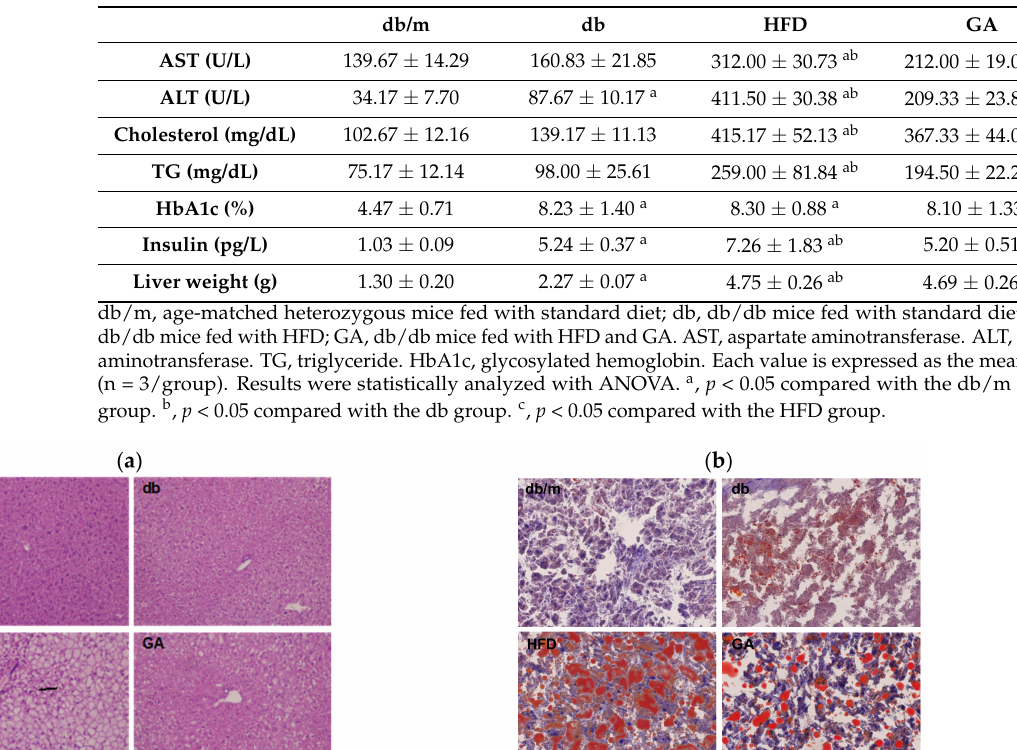
Table 1. The plasma biochemical parameters and liver weight in mice.